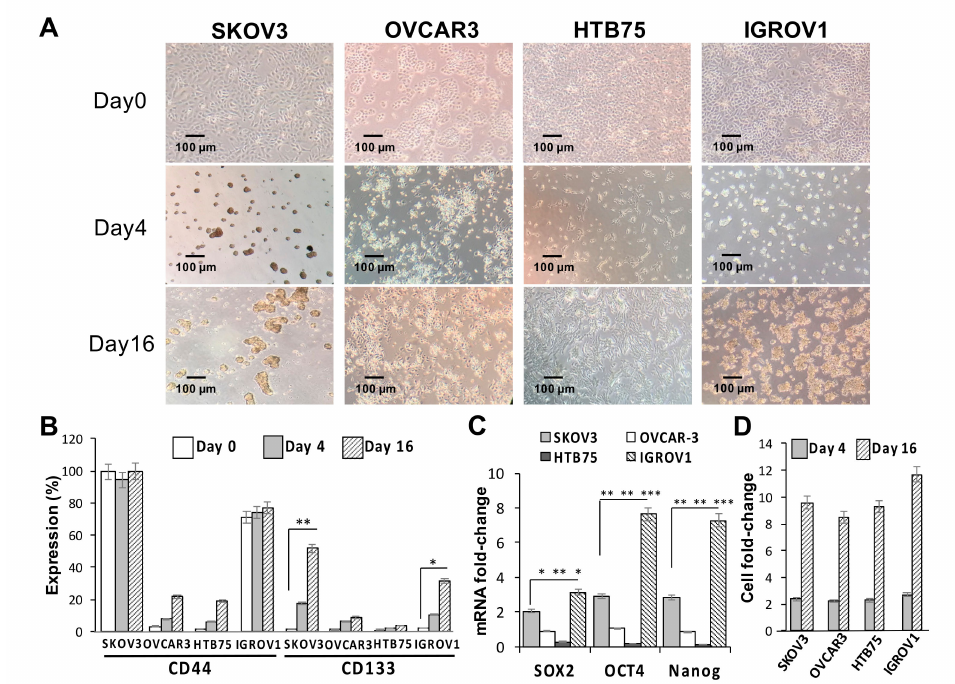
Figure 1. Sphere-forming ability and expression of stemness-related markers of human ovarian cancer (OC) cell lines. ( A ) Optical microscopic images showed morphological changes and sphere formation of SKOV3, OVCAR3, HTB75, and IGROV1 cells at days 0, 4, and 16. Individual scale bars are shown. OC-sphere cells collected at each time point for ( B ) cell surface expressions of cluster of di ff erentiation 44 (CD44) and CD133 were assessed using flow cytometry; ( C ) expression of the stemness-related markers Sox2, Oct4, and Nanog on day 16 were assessed using RT-qPCR; and ( D ) sphere cell numbers. * p < 0.05, ** p < 0.01, *** p <